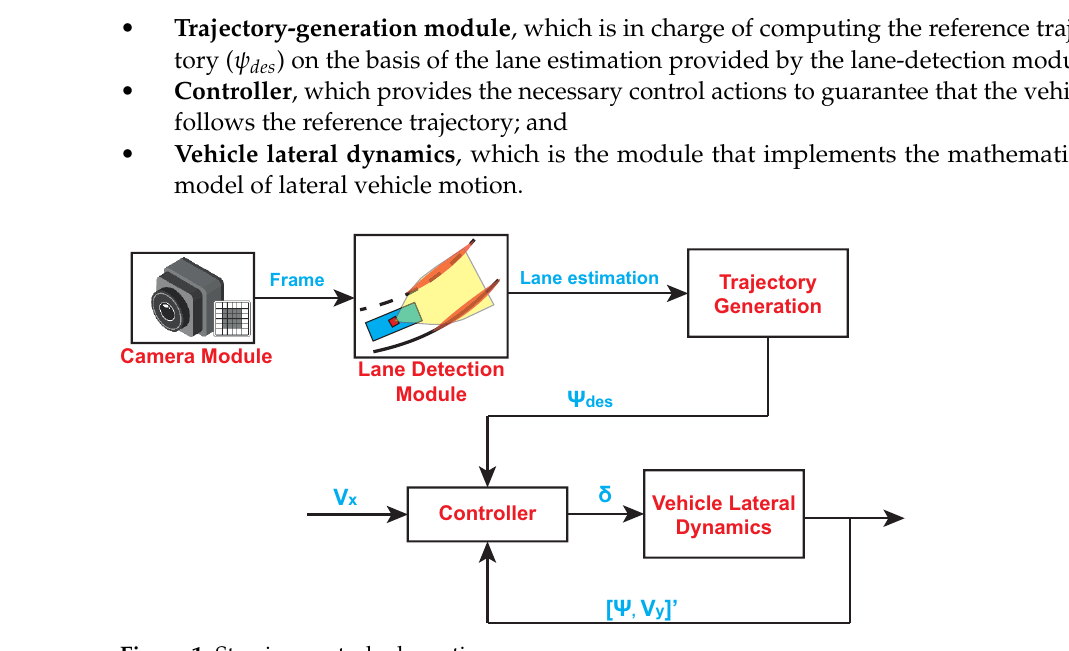
Figure 1. Steering control